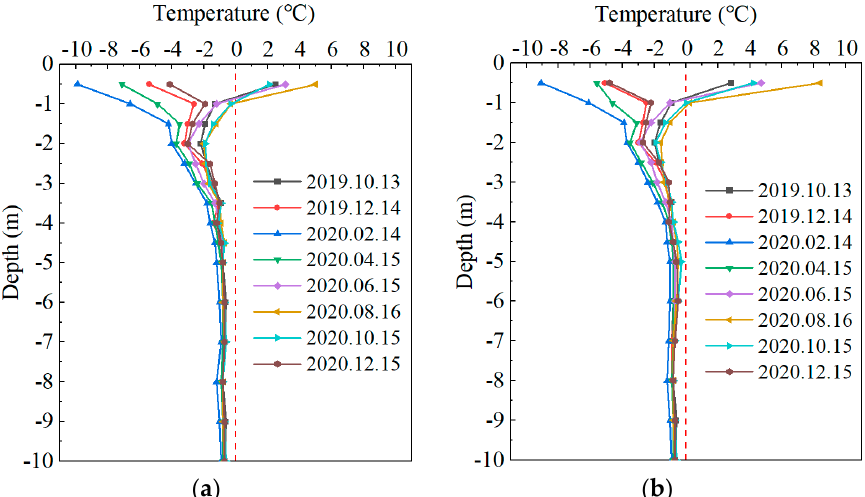
Figure 6. Variation of underground temperature with depth. ( a ) The underground temperature in borehole T1 covered with vegetation; ( b ) the underground temperature in borehole T2 covered without vegetation.